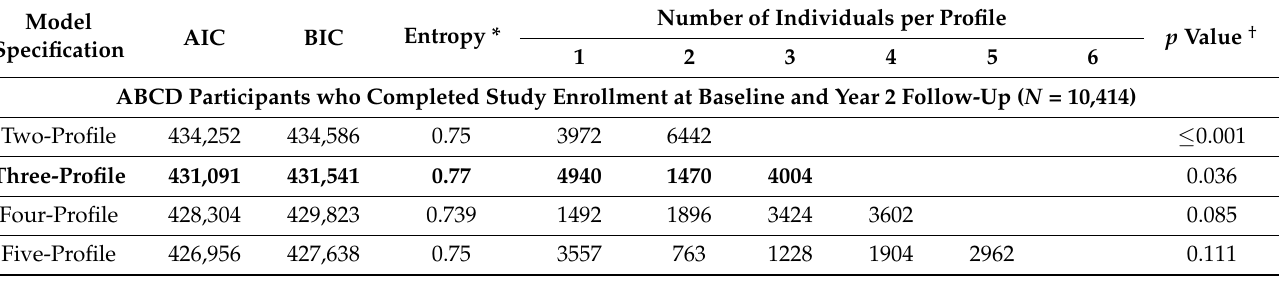
Table 2. Fit statistics for latent profile model specification at baseline study enrollment ( N =